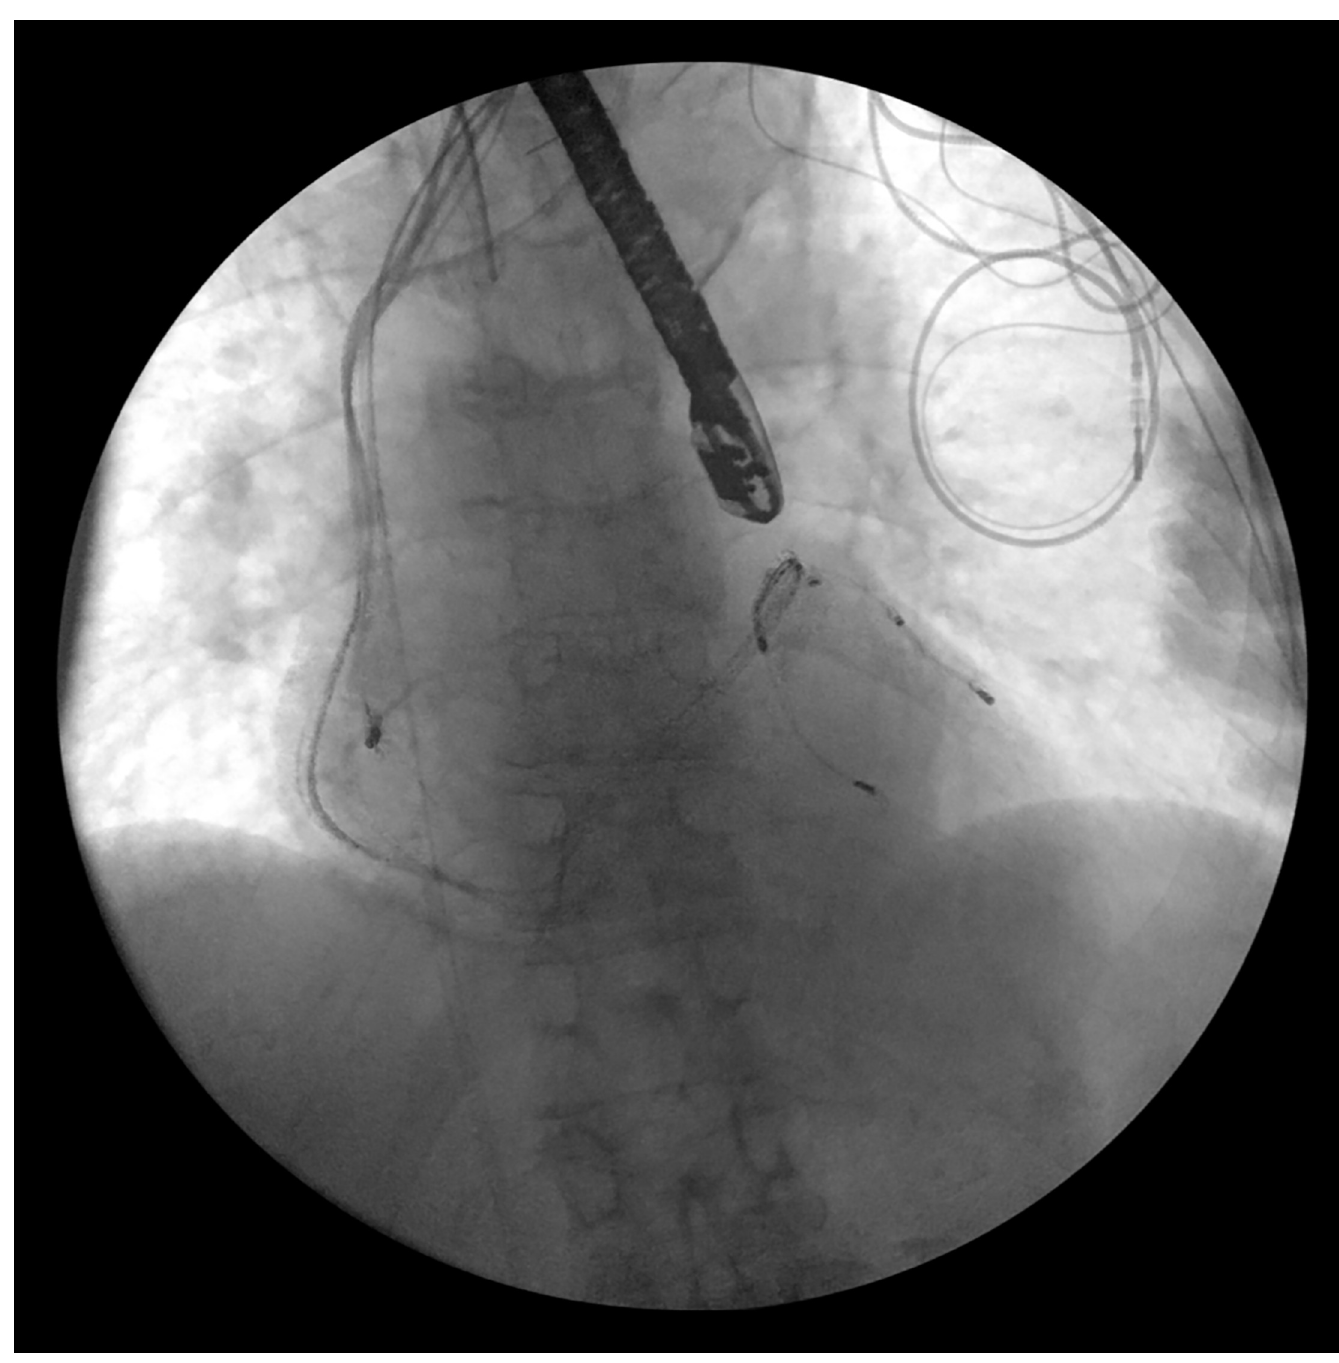
Fig 6. Retraction of the laser